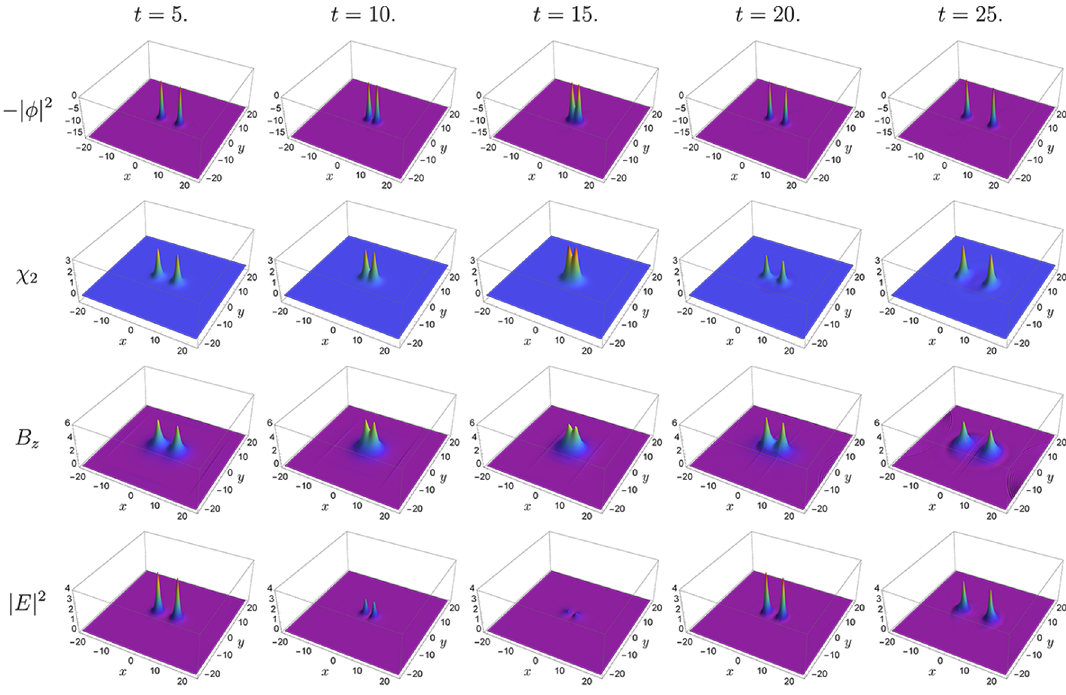
Figure 21 . Snapshots of −| φ | 2 , χ 2 , B z and | E | 2 for head-on scattering of type II parallel non- Abelian vorticet with initial velocity u = 0 . 5